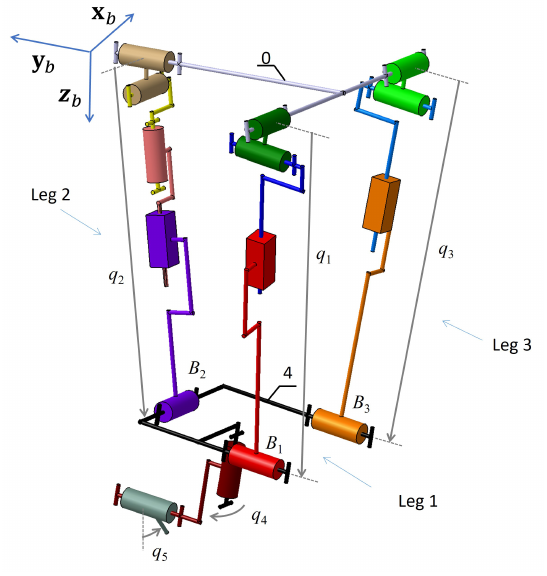
Figure 2. Kinematic model of Tripteor X7 PKM.